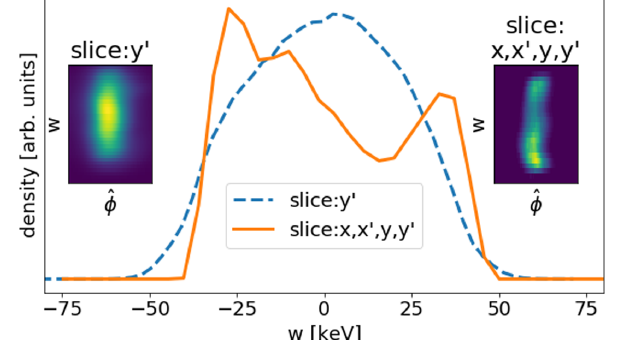
FIG. 1. Measured energy distribution for two levels of partial projection: a 1D core slice and 4D core slice. The longitudinal phase spaces are plotted in a shear-corrected plane, where ˆ ϕ ¼ ϕ − h d ϕ i w . The beam current during the measurement is dw 21 mA. This plot is consistent with results in [4], but reproduced with more recent measurements.